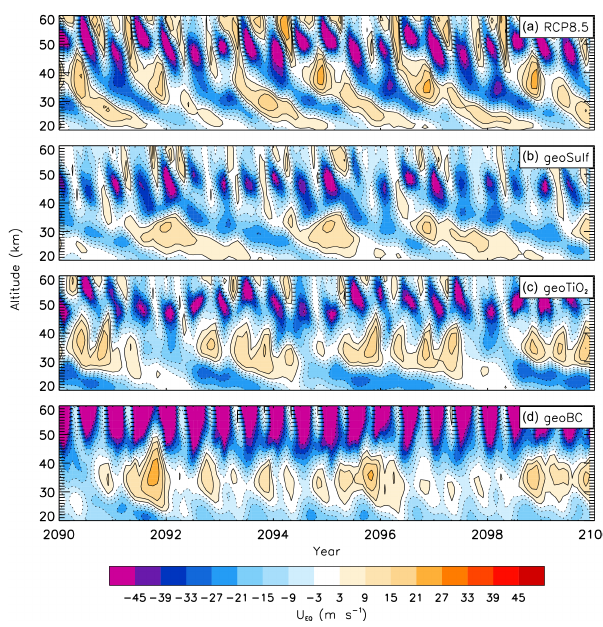
Figure 12. Time series of equatorial (5 ◦ S–5 ◦ N) zonal-mean zonal wind